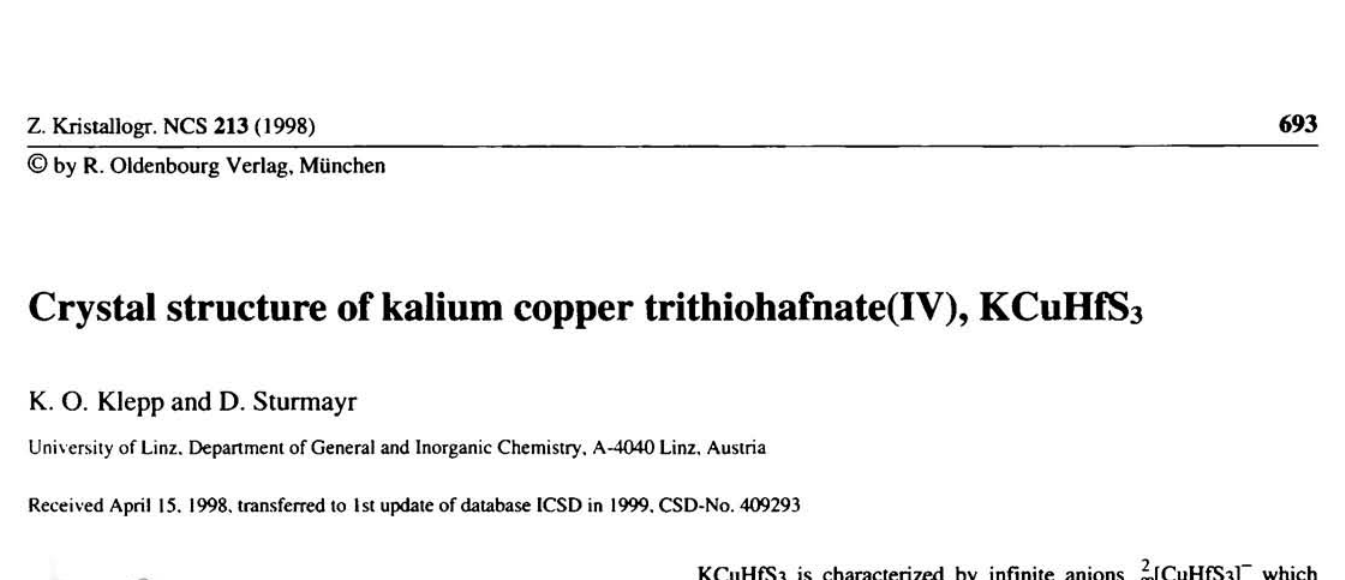
Table 1. Parameters used for the X-ray data collection